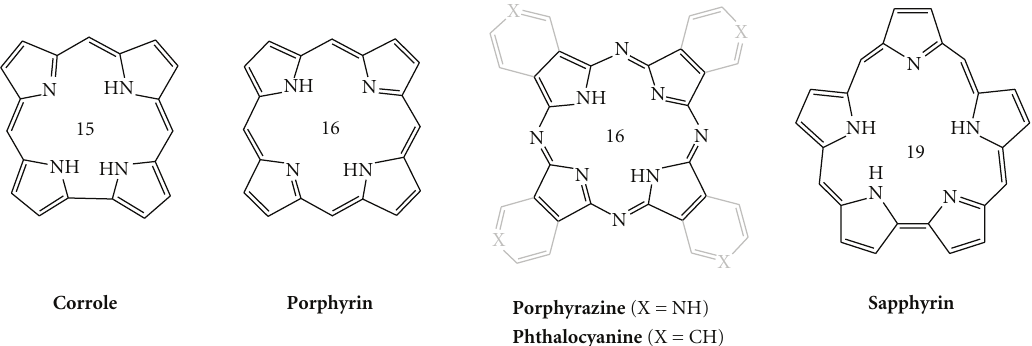
Figure 8: Polyheterocyclic macrocyclic cores used in the structures of G-quadruplex ligands. The number in the center corresponds to the number of atoms in the central